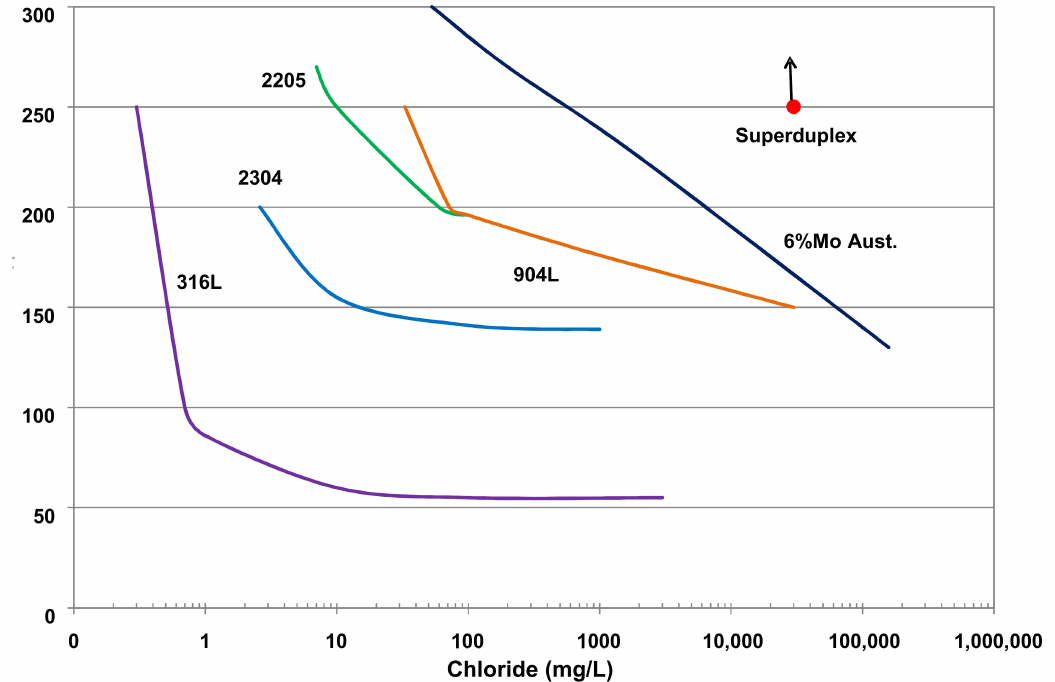
Figure 18. Threshold temperature/chloride regions for SCC (stress corrosion cracking) of some common stainless steels